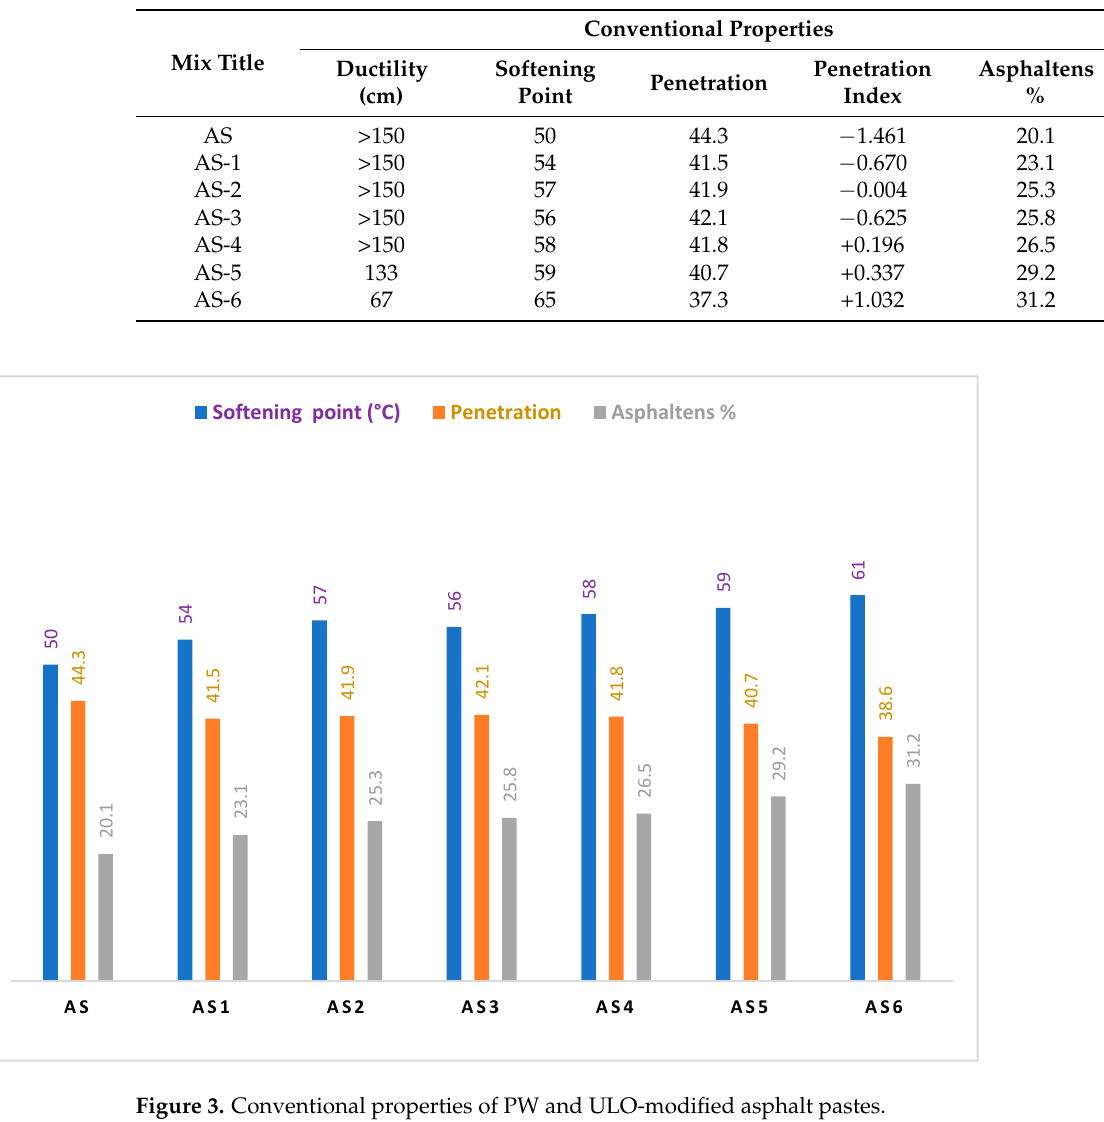
Table 5. Conventional properties of PW and ULO-modified asphalt pastes.